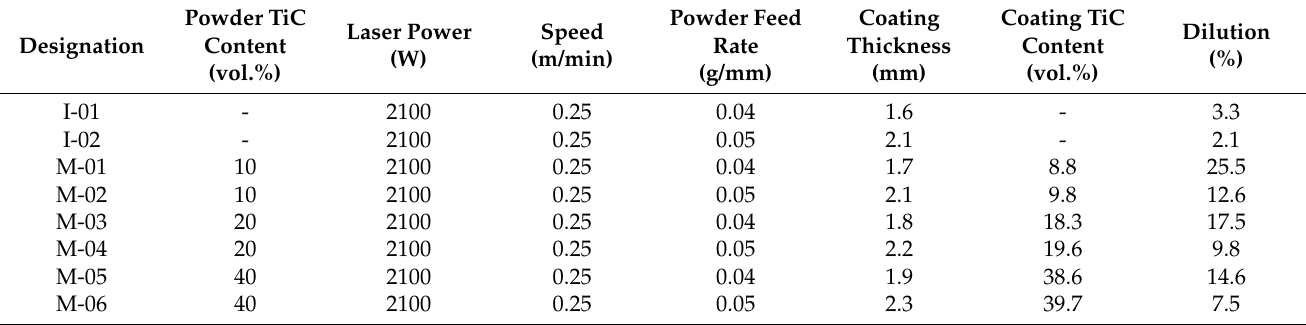
Table 3. Laser cladding